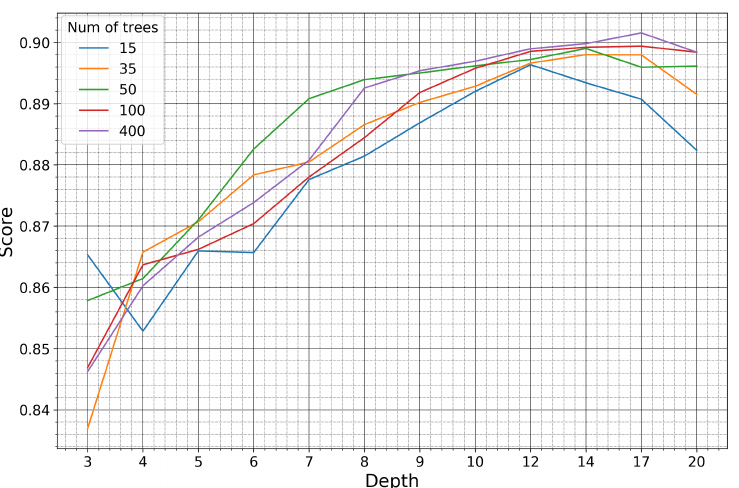
Figure 11. Kappa coefficient of the Cheorwon site for models trained on pseudo-labels of the Seosan-Dangjin site, with various depth sizes and number of